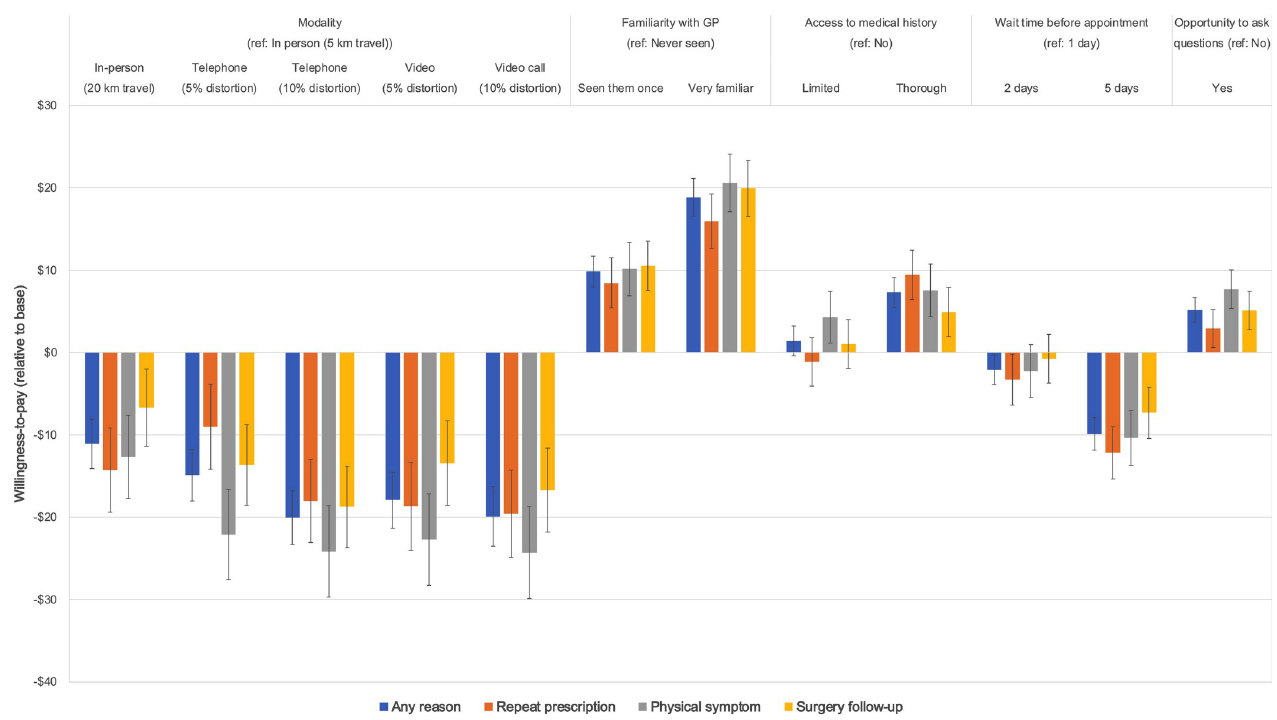
Fig 2. Willingness to pay threshold analysis, by